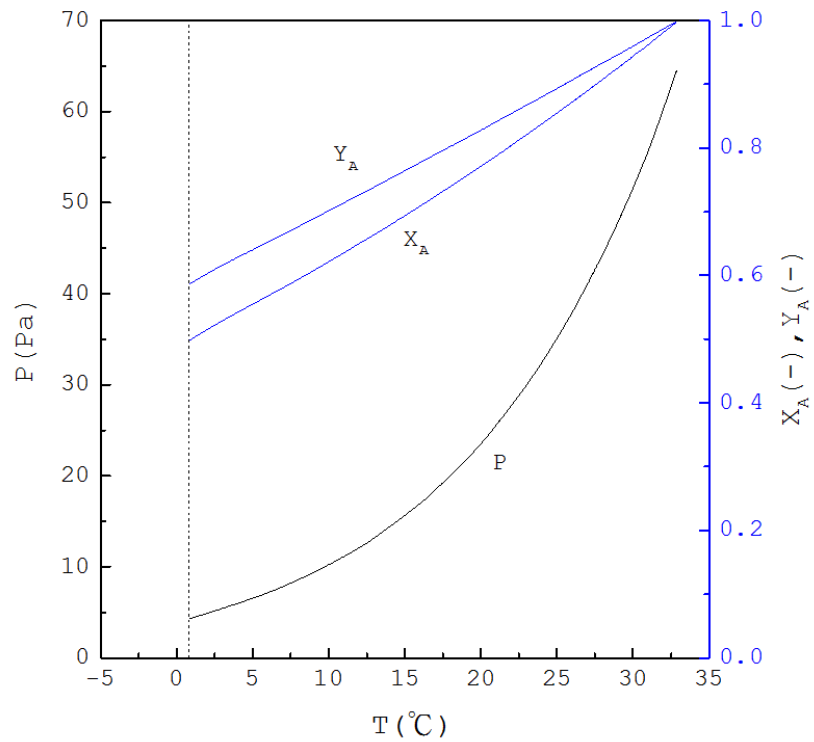
Figure 5. The calculated results of P ( T ) , X A ( T ) and Y A ( T ) for the formation of m -chlorophenol solid product from the liquid mixture via the three-phase transformations.